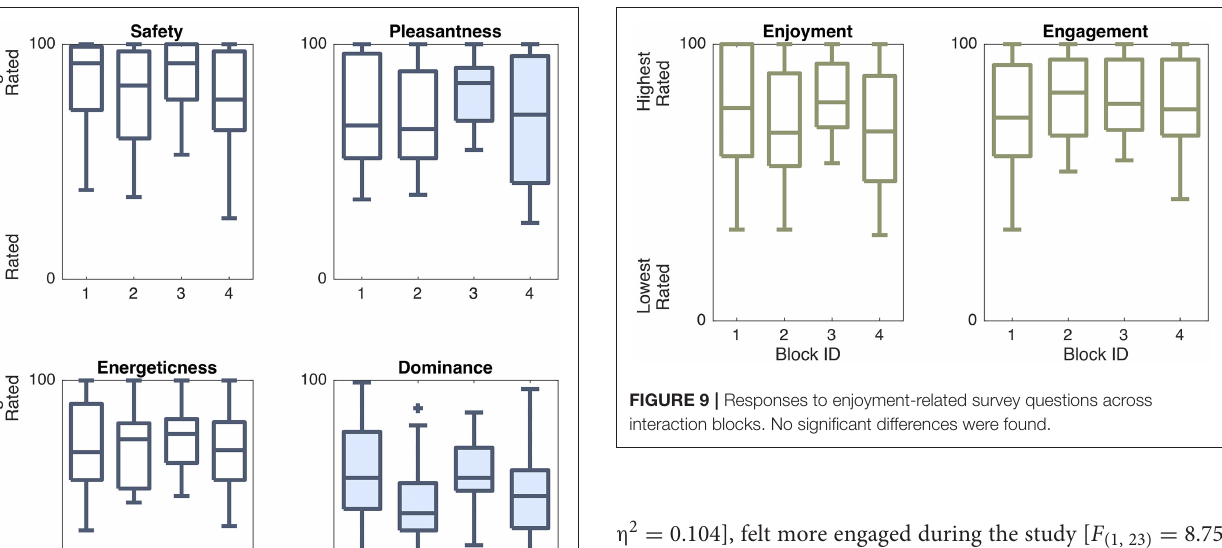
η 2 = 0.104], felt more engaged during the study [ F p = 0.004, η 2 = 0.085], and felt more rushed during the interactions [ F (1, 23) = 11.15, p = 0.001, η 2 =